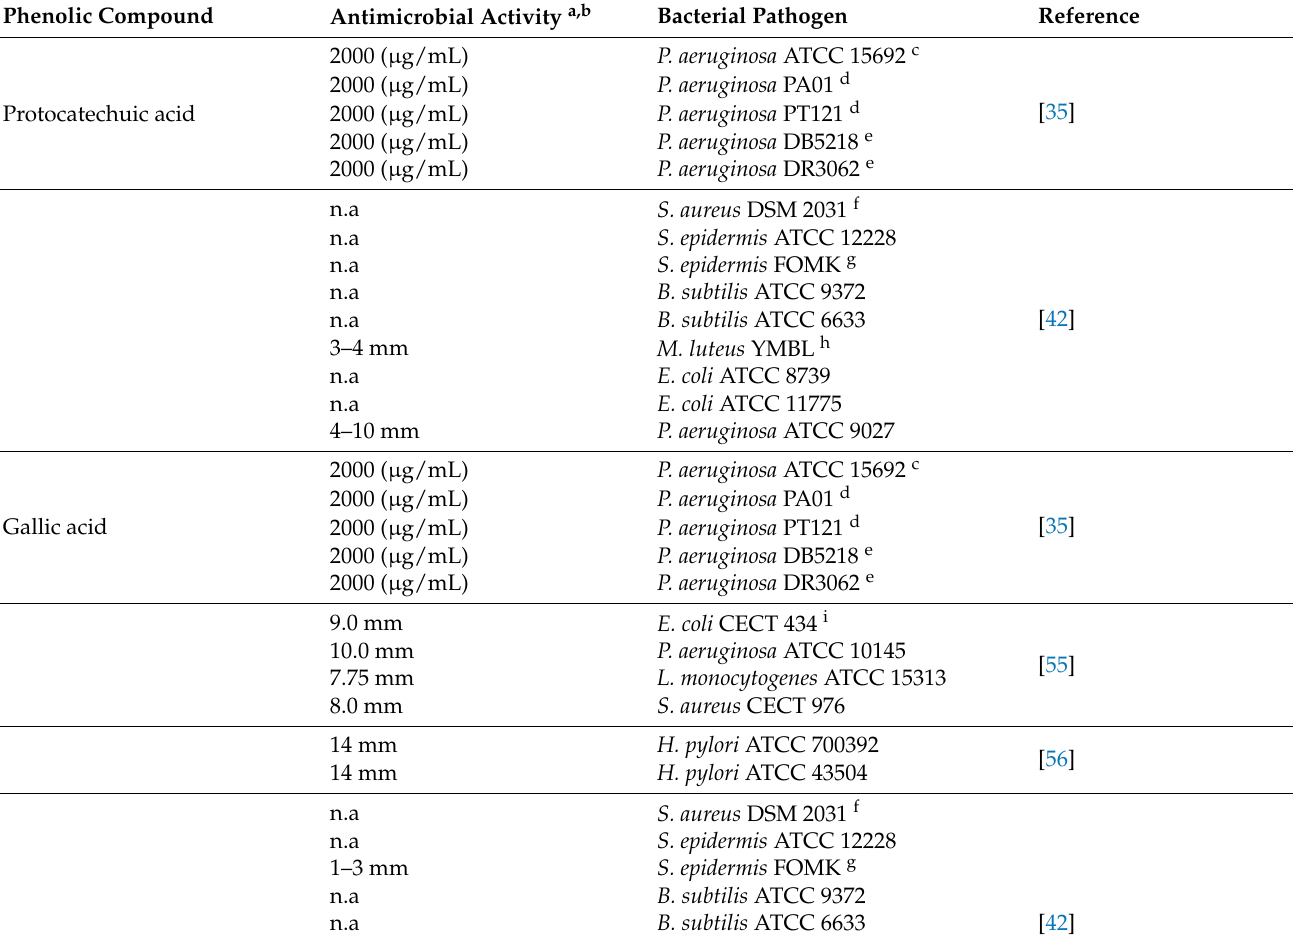
Table 2. Plant phenolic compounds and their antimicrobial activity against human pathogens. Phenolic